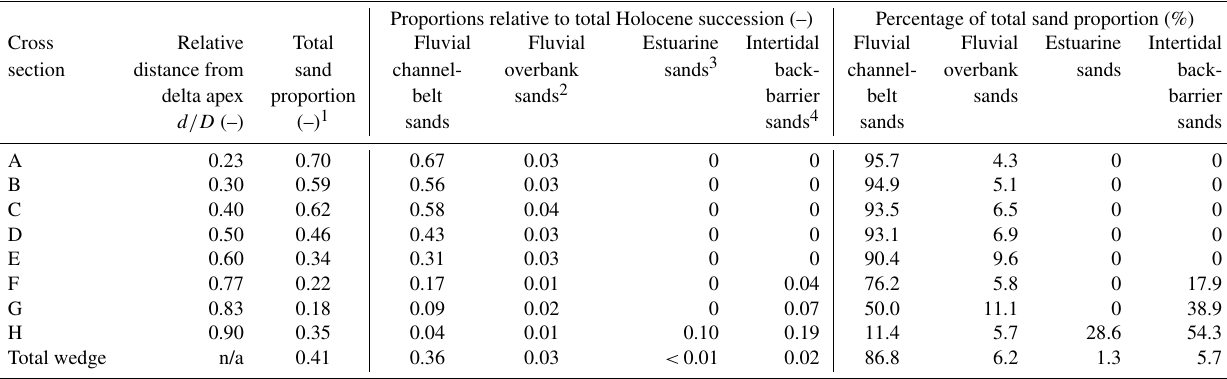
n/a 0.41 0.36 1 Total sand proportion is the sum of fluvial channel sands (CDP), fluvial overbank sands, estuarine sands and marine sands. 2 Sands in crevasse splays and lake deposits (“coarse-grained overbank deposits”; see Bos and Stouthamer 2011). 3 Notable bay–head delta deposits (Hijma et al., 2009); data are from Bos and Stouthamer (2011). 4 Sandy intertidal deposits, mainly tidal channel fills. n/a stands for not